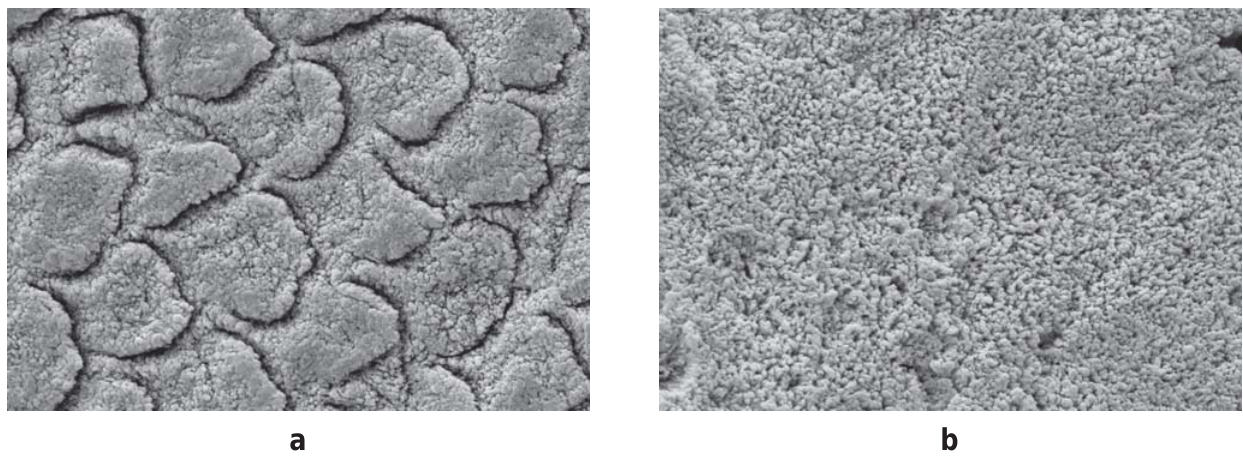
FIGURE 9- SEMs of ground (9a) and intact (9b) enamel surfaces treated with Tyrian SPE self-etching primer. Aggressive etching effect similar to phosphoric acid etching in grounded enamel surfaces (9a). The application to intact enamel exposed enamel crystallites along the surface (9b)